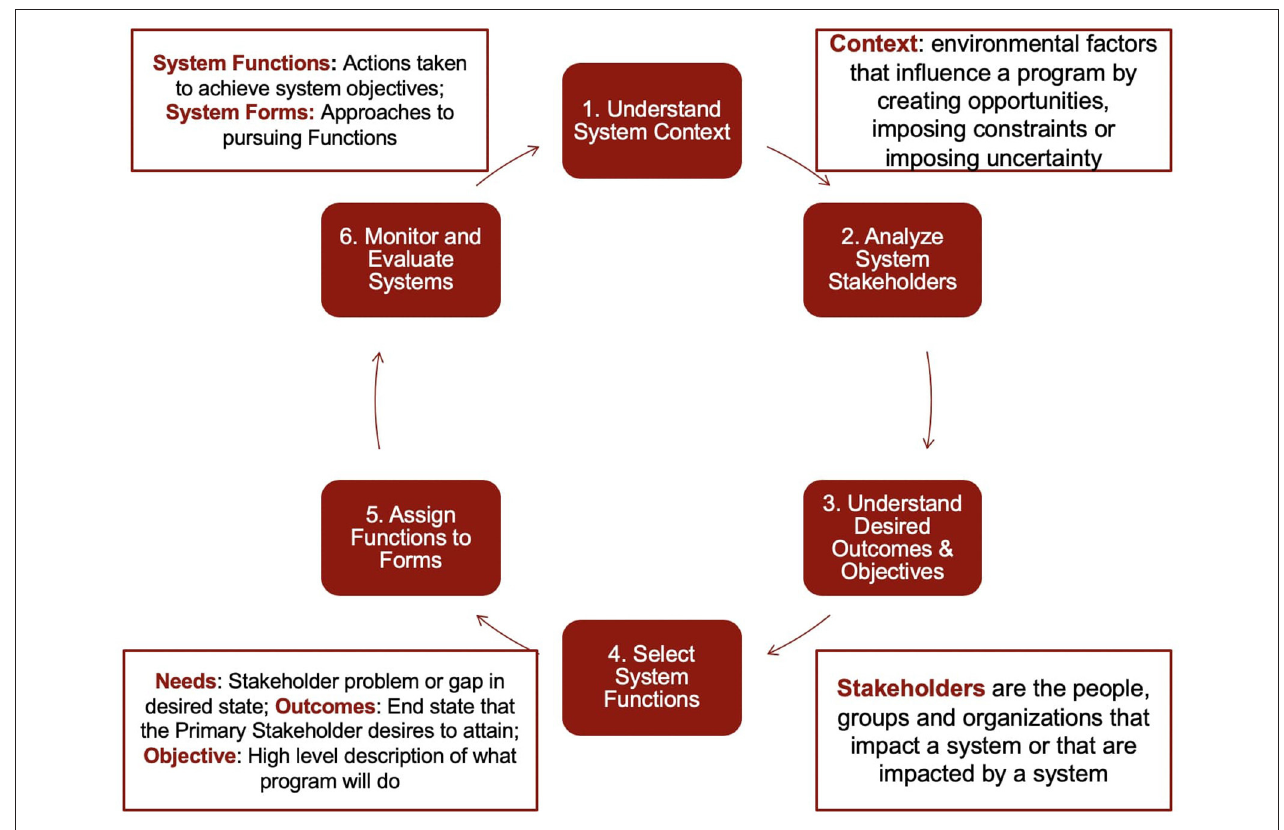
FIGURE 2 | The Systems Architecture Framework provides six steps to design and evaluate a complex, socioenvironmental system. Credit: Danielle